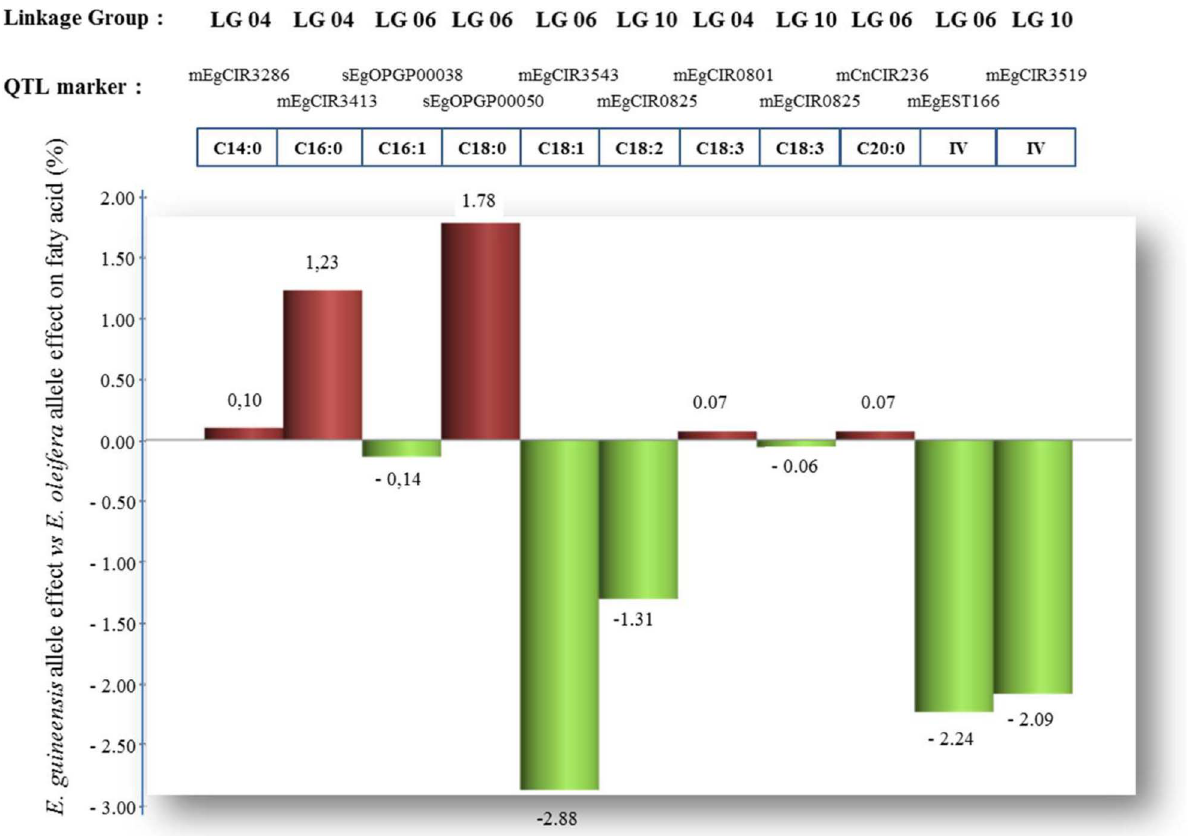
Figure 3. Effects of E.guineensisversusE.oleifera QTL alleles on the palm oil fatty acid composition, estimated by Montoya et al. [27] from the interspecific pseudo-backross SA569. Note: the QTL marker loci were used to perform an ANOVA test (type III, post hoc test of Tukey at a =0.05) to estimate the mean effects of the parent QTL marker alleles on the mean of each phenotypic trait. For the hybrid parent SA65T, the species origin of the QTL marker alleles were identified, and the allelic effects at the QTL were therefore estimated by contrast of E. oleifera (grand- parent SA49D) against E. guineensis (grand-parent LM2466P).